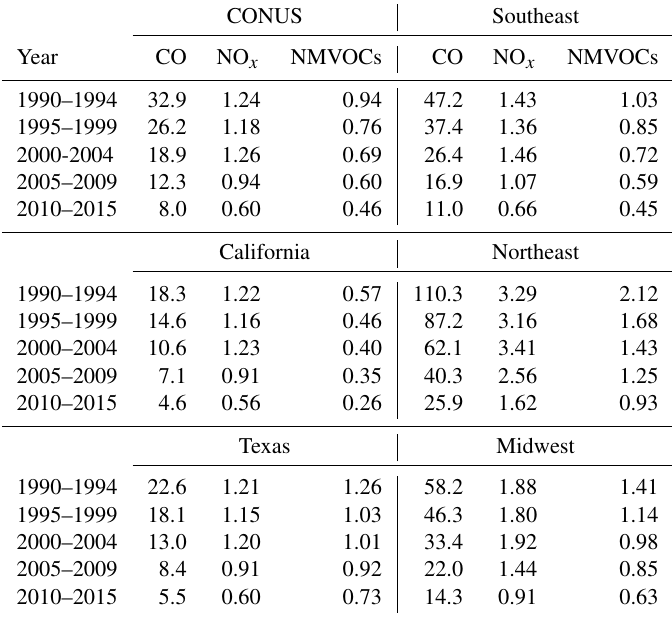
Table 1. Summary of multiyear mean average of daily CO, NO x and NMVOCs emissions in the CONUS and five subdomains (in moles per square kilometer per second). Please note that our California and Texas subdomains include more area than the states of California and Texas. CONUS Southeast Year CO NO x NMVOCs